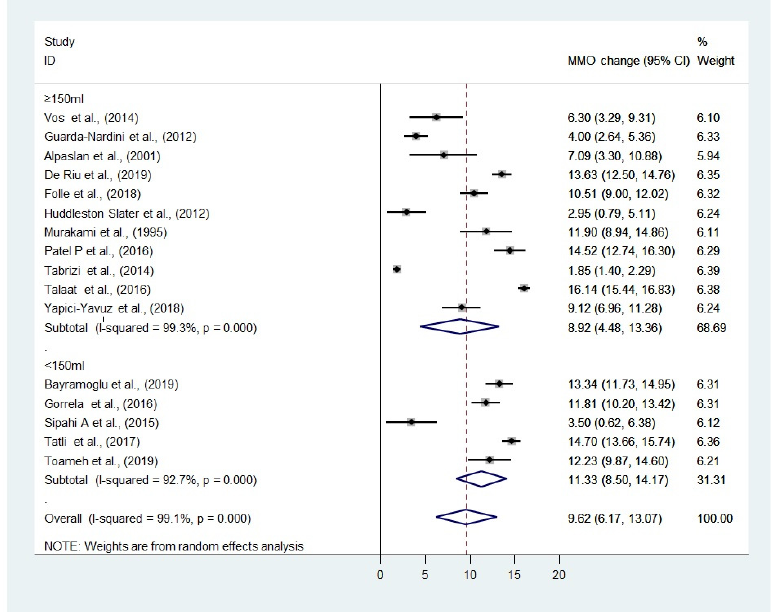
Figure 2 Figure 2. Forest plot using the random effects models showing the weighted mean difference (WMD) in the maximal mouth opening (MMO) between the two groups: all studies included. (Heterogeneity between the studies quantified using the I 2 and p -value of the Chi 2 test were listed) [19,23,29–42].